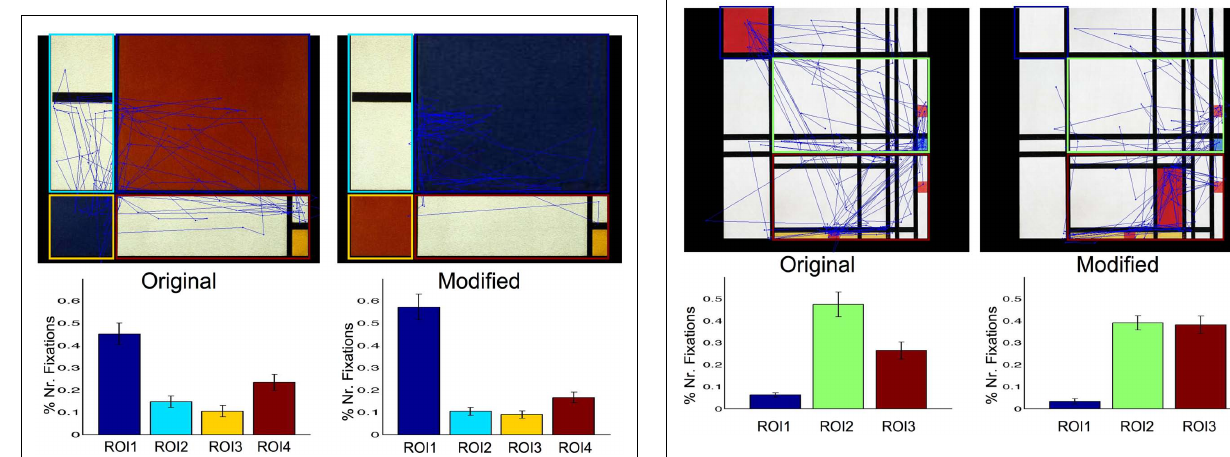
FIGURE 2 | Original (left) and modified version (right) of Mondrian’s “Composition II in red, blue, and yellow,” with the fixation patterns of a subject superimposed. For both versions of the painting we defined four regions of interest (ROI1 in blue, ROI2 in cyan, ROI3 in yellow, and ROI4 in red) and the average relative number of fixations in each region is shown on the bottom. In the modified version, the large blue patch attracts most fixations, thus breaking down the balance of the original painting.